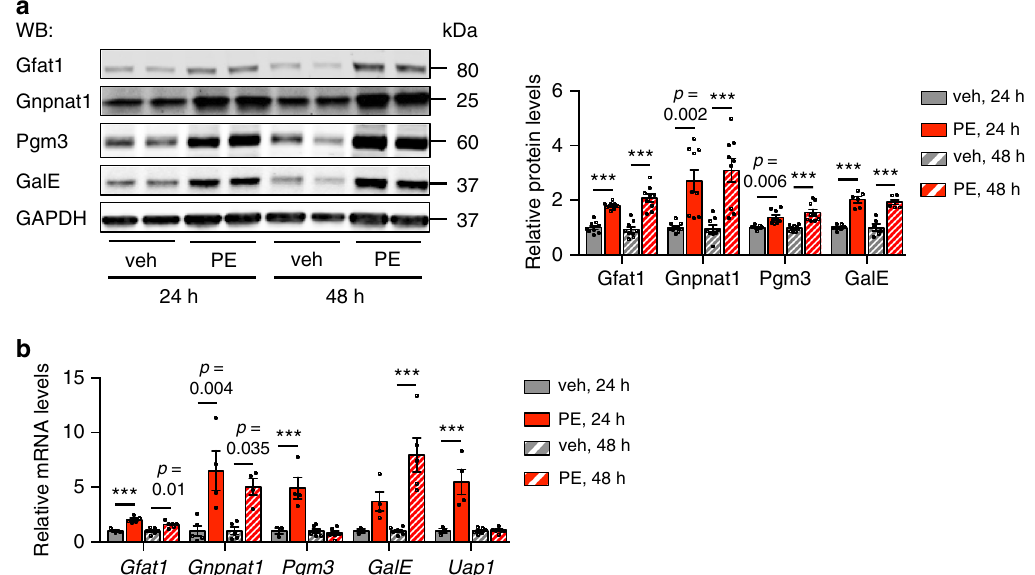
Fig. 1 Induction of the hexosamine biosynthetic pathway in cardiomyocytes. a Neonatal rat ventricular myocytes (NRVMs) were treated with phenylephrine (PE, 50 μ M) for 24 and 48 h, respectively. Representative immunoblots of the hexosamine biosynthetic pathway (HBP) enzymes (Gfat1, Gnpnat1, Pgm3, and GalE) are shown. Quanti fi cation (right) indicates signi fi cant upregulation of the HBP by PE treatment in cultured cardiomyocytes. N = 6 for GalE quanti fi cation and n = 9 for all other proteins. b PE treatment led to strong increases of the HBP enzymes at the mRNA level. N = 3 – 6. Data are shown as mean ± SEM. Signi fi cance was calculated by two-way ANOVA, followed by Tukey ’ s test. *** p < 0.001. Source data are provided as a Source Data fi le.